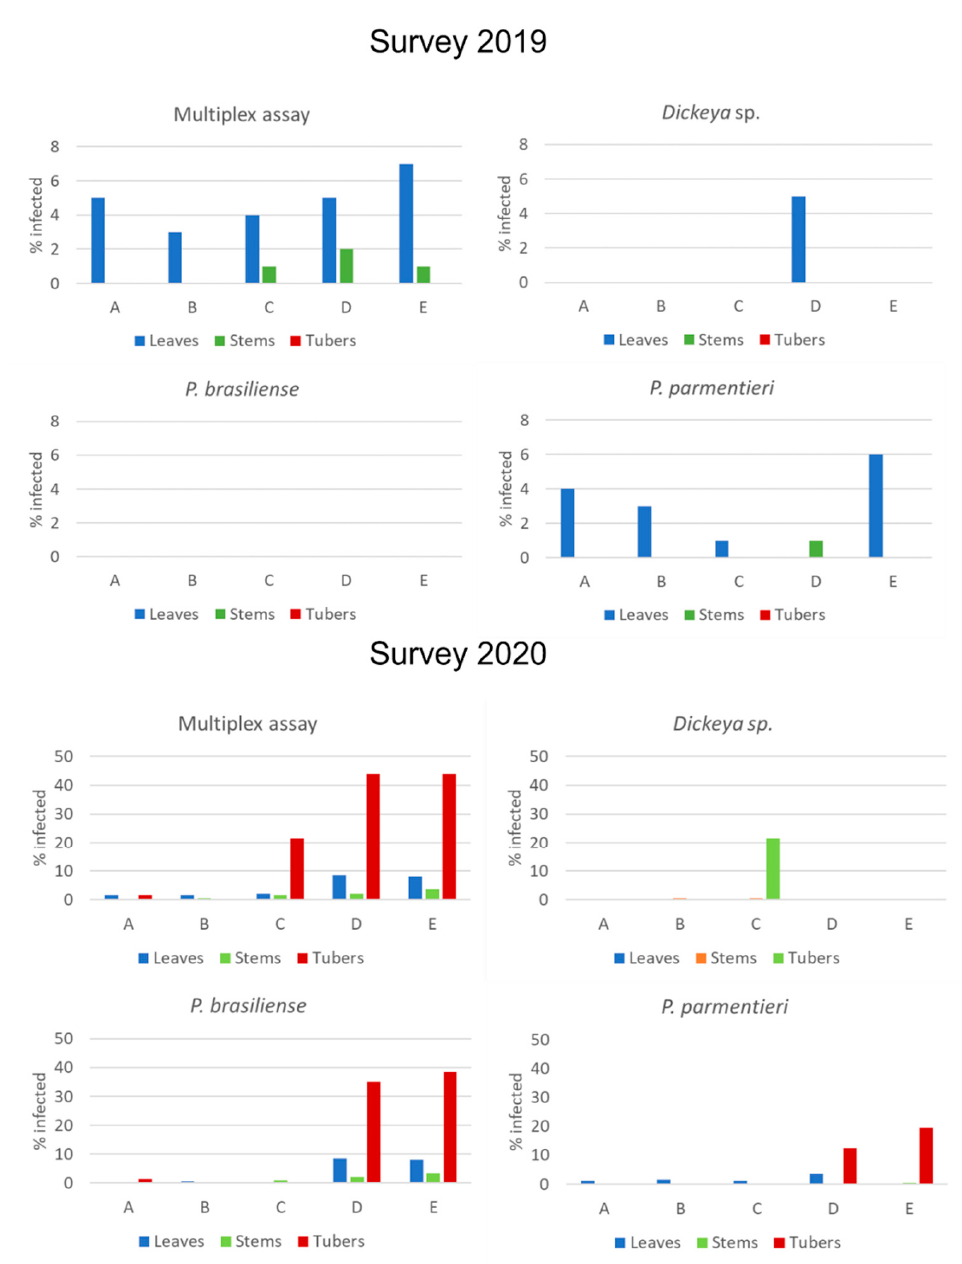
Figure 1. Results of an analysis of leaves, stems, and tubers of potato plants grown from minitubers at five growers (A–E) with a multiplex TaqMan assay detecting simultaneously Dickeya sp., Pectobac- terium brasiliense, P. parmentieri, and P. atrosepticum followed by identification of positive results using simplex assays against the target pathogen. In 2019, 100 individual plants per grower were sampled. In 2020, 200 plants were sampled per